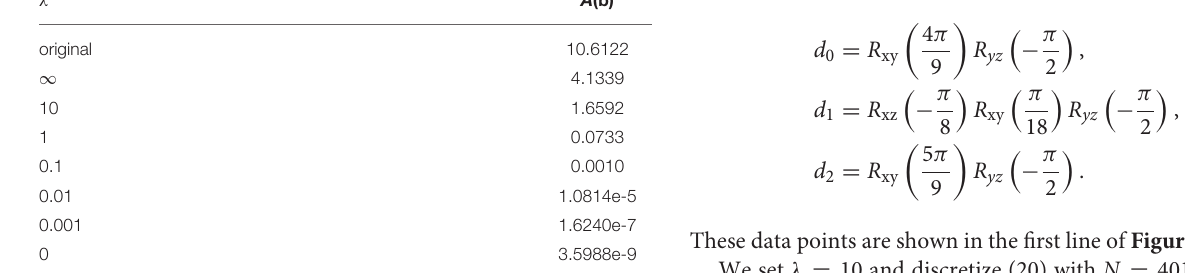
TABLE 1 | Functional values for the three-segment composite Bézier curve on the sphere and different values of λ . λ